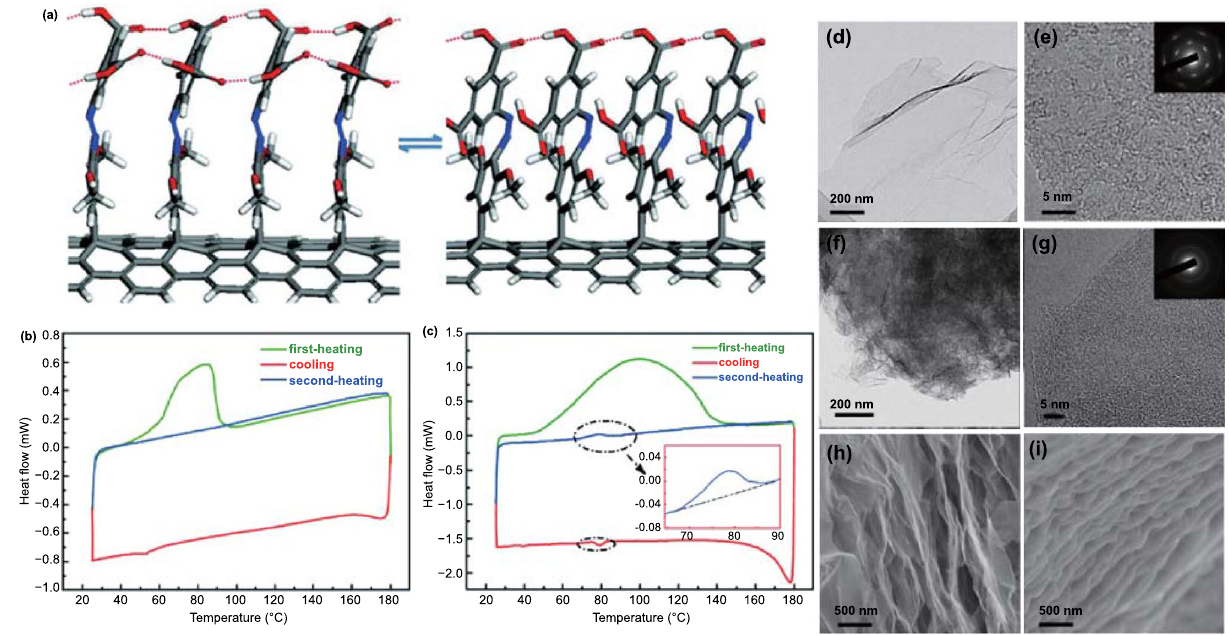
Fig. 11 a Stable models of trans and cis isomers of Azo–RGO-1 obtained using DFT calculations. DSC traces of b Azo and c Azo–RGO-1 with first-heating (green), cooling (red) and second-heating (blue) periods. TEM images of d RGO with e a high resolution, f Azo–RGO-1 with g a high resolution and SEM images of h RGO and i Azo–RGO-1 [100]. (Color figure online)